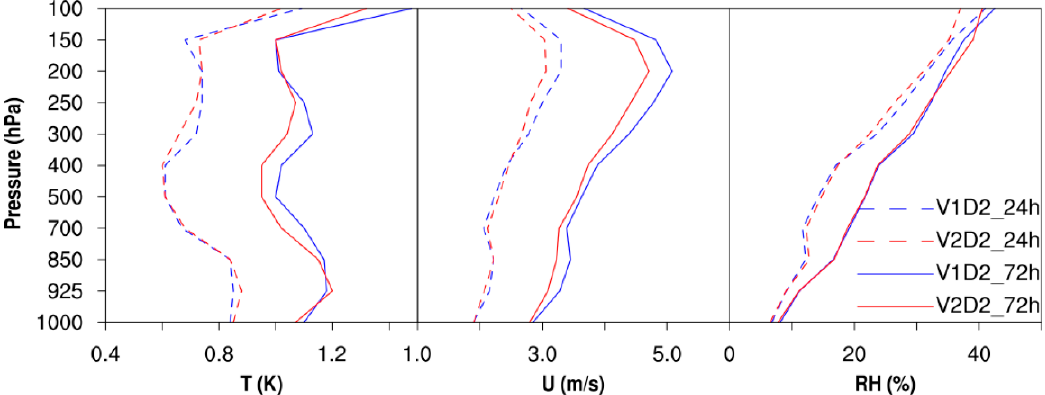
Figure 7. Same as in Figure 6 except for the V1D2 and V2D2.